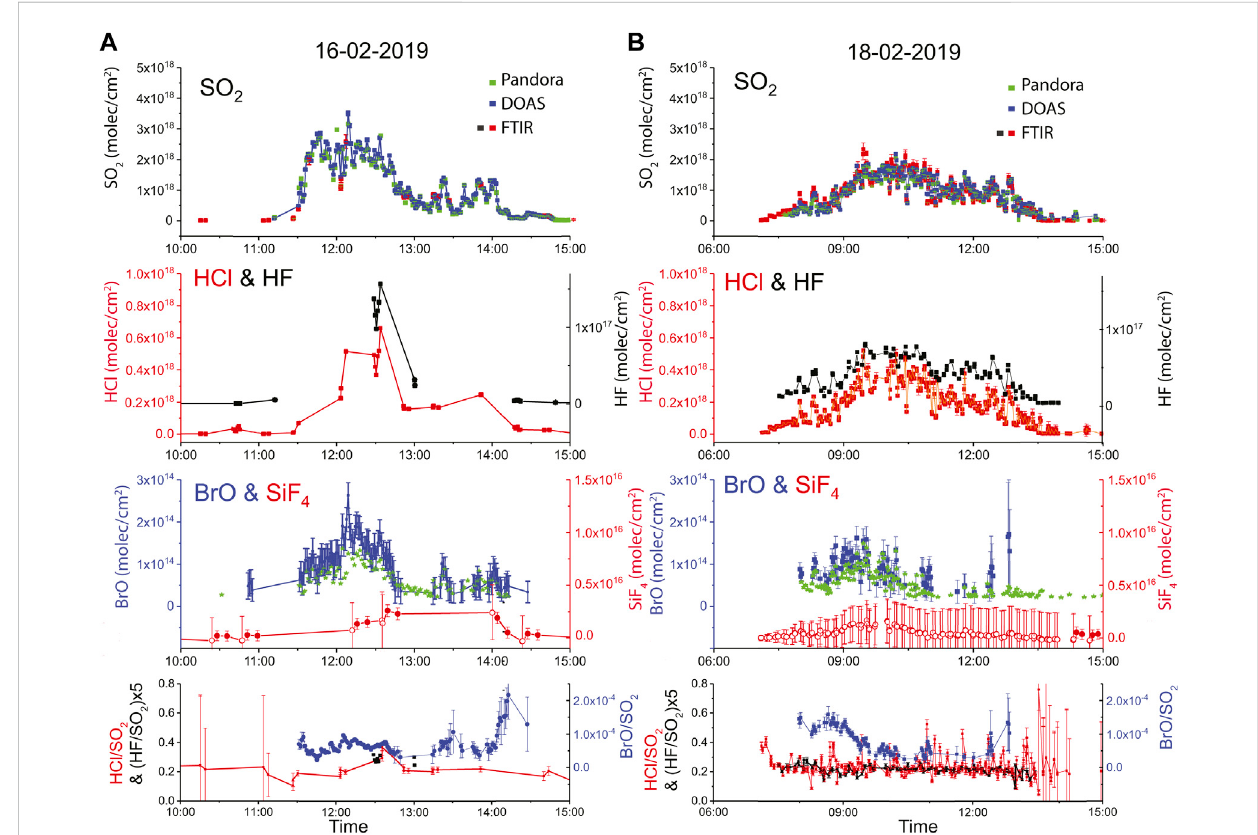
FIGURE 6 SO 2 , HCl, HF, BrO, SiF 4 VCs intraday time series captured on the (A) 16 February 2019 and (B) 18 February 2019 using the S2000 DOAS, FTIR and Pandora instruments. For SiF 4 , open and full circles correspond to the low and high resolution products, respectively. The BrO from the Pandora instrument [third (A) and (B) panels, in green] corresponds to a non-of fi cial PNG product and is only indicative of the S2000 DOAS and Pandora BrO VCs agreement. The lower panel shows the time series of the HCl/SO 2 , HF/SO 2 ( × 5) and BrO/SO 2 ratios. See text for more